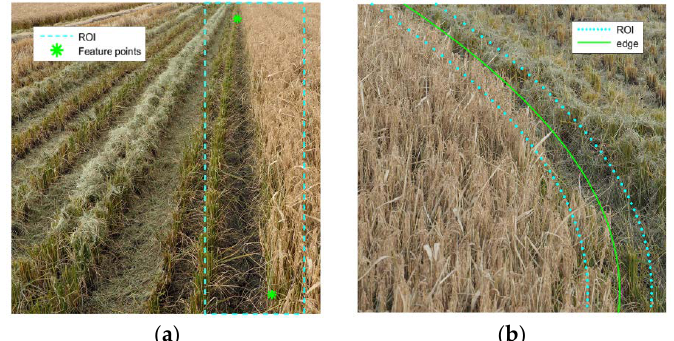
Figure 6. Region of interest (ROI) extraction results: ( a ) Initial ROI extraction; ( b ) Dynamic ROI extraction.